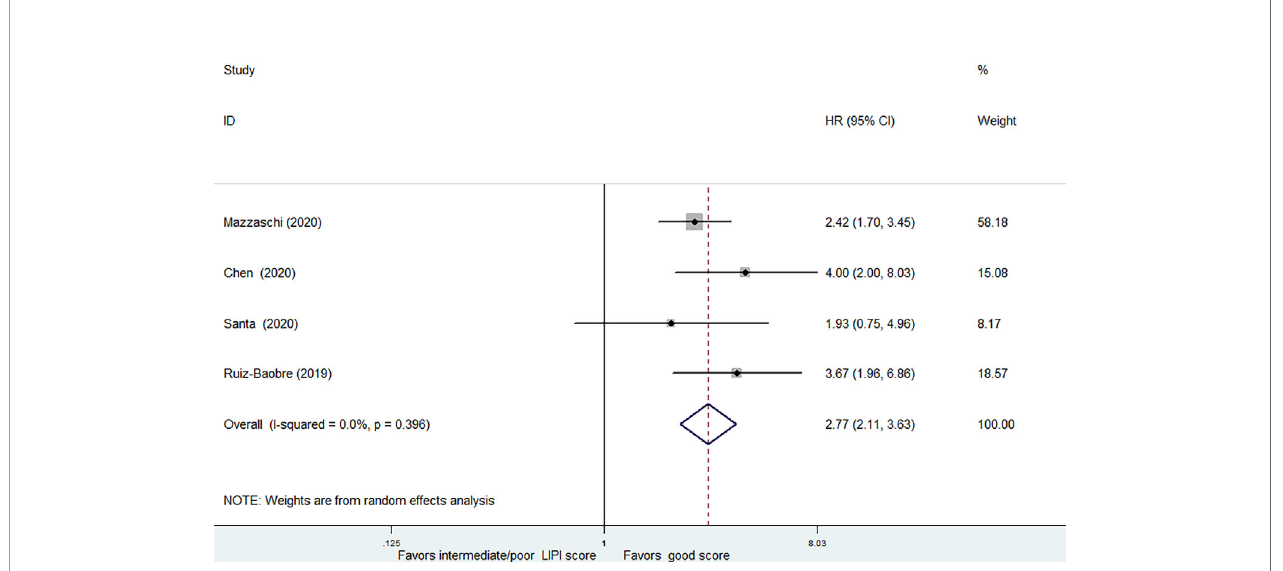
FIGURE 4 | Meta-analysis of OS in cancer patients after ICIs treatment (intermediate + poor LIPI score groups vs. good LIPI score